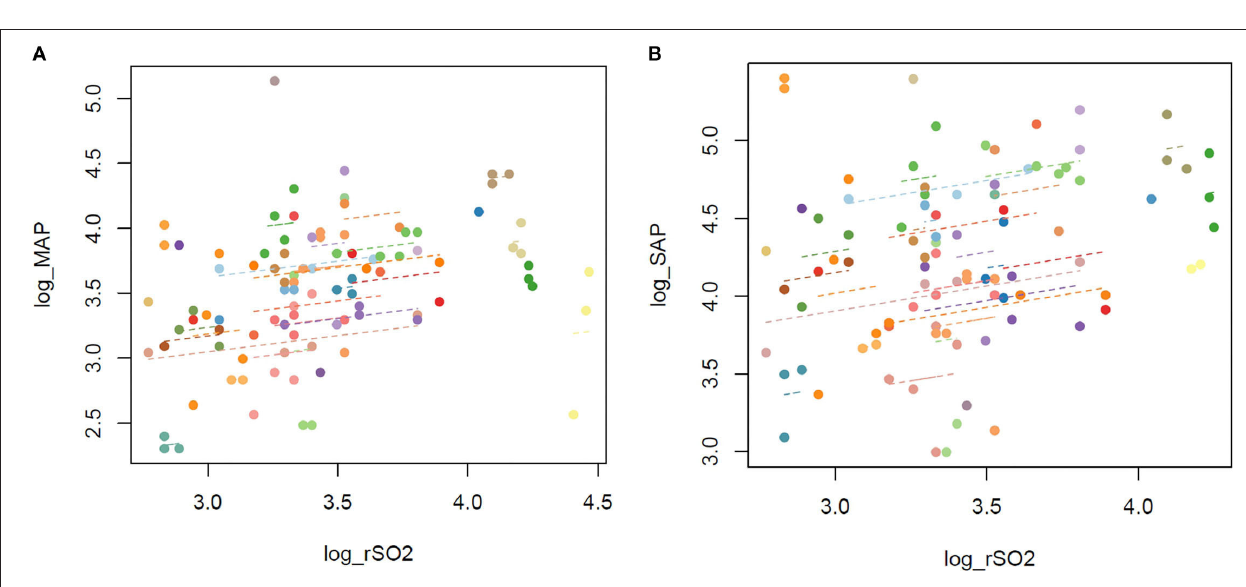
oxygen saturation. In summary, chest compressions might